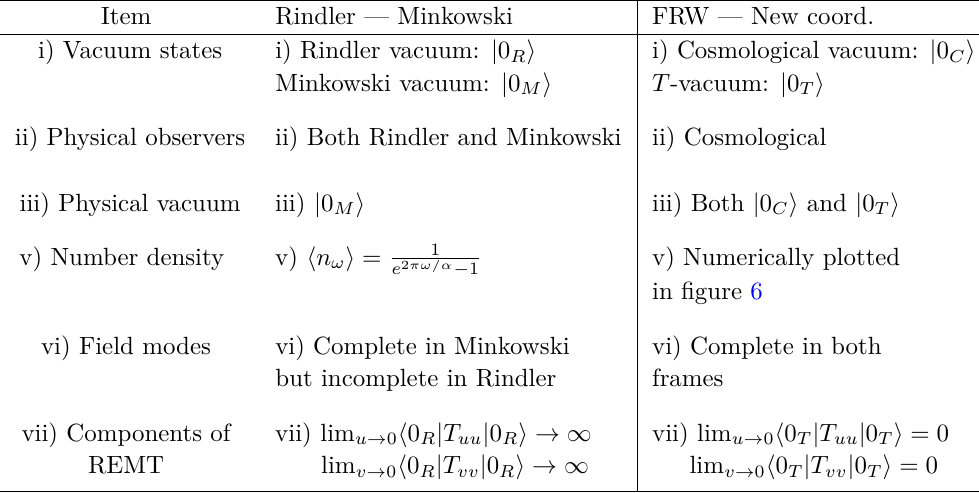
Table 2 . Comparison between the particle creation in this paper with the Unruh